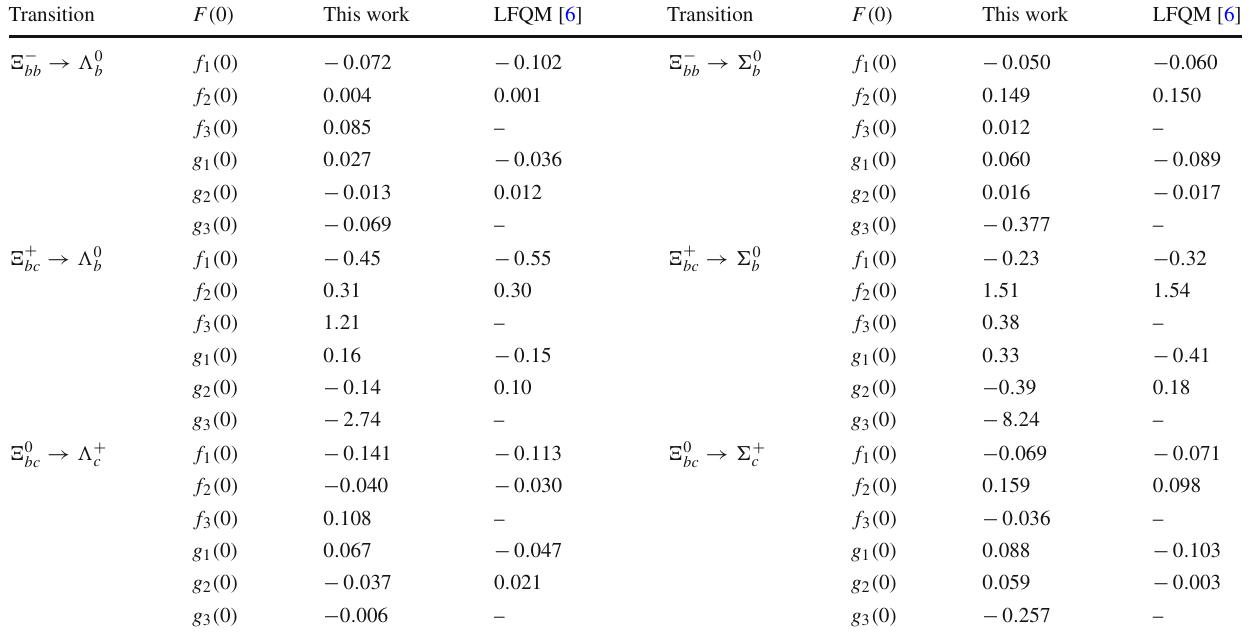
→ (cid:3) 0 ,(cid:6) 0 , (cid:2) + bb bc b b b b